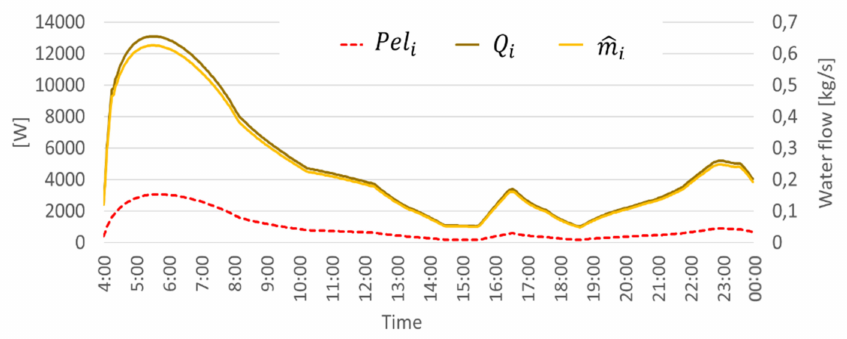
Figure 6. Pel i , Q i and control variable values ˆ m i in the MPC approach.